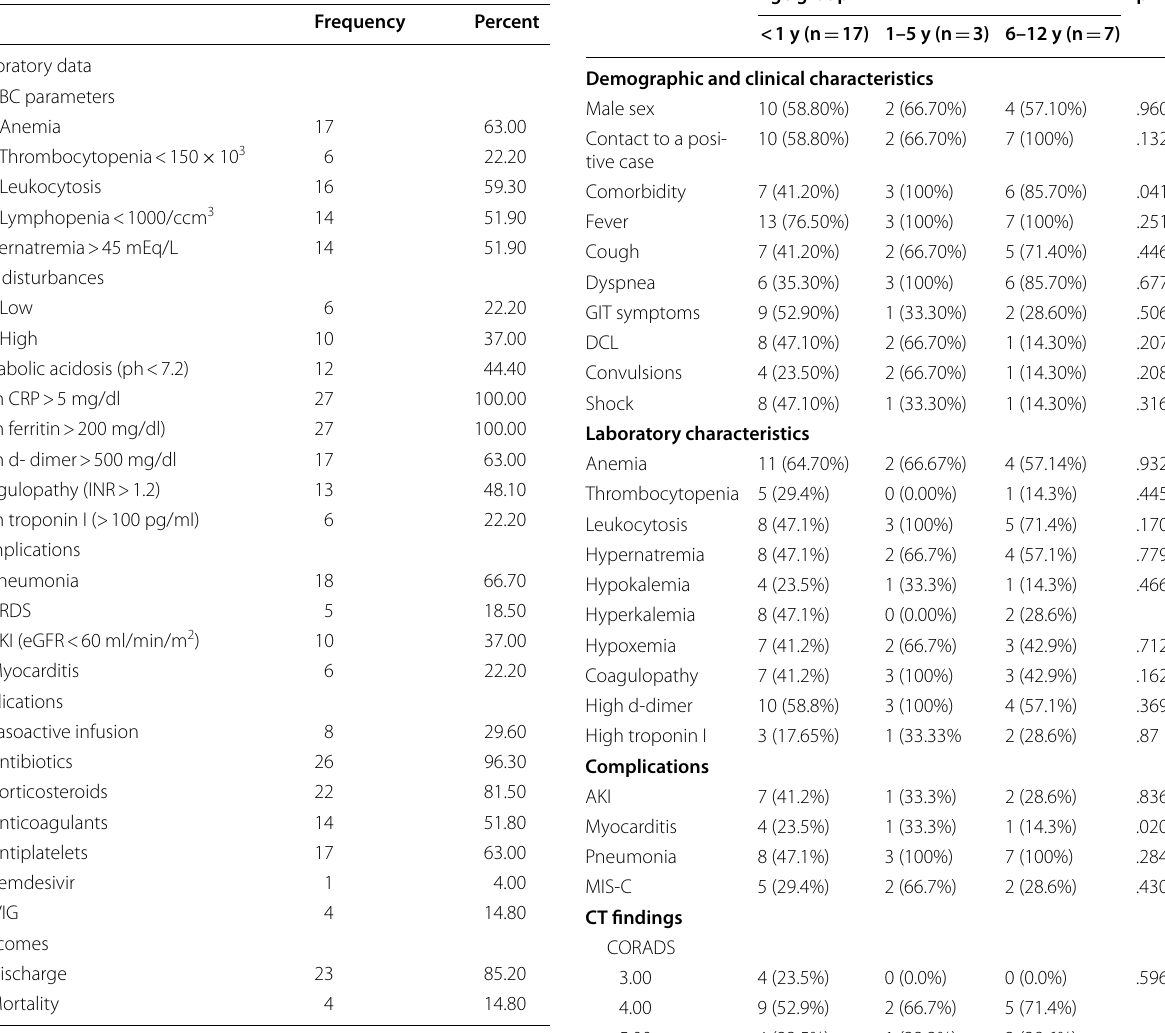
Table 1 Clinical and laboratory characteristics of the study group (27 patients)